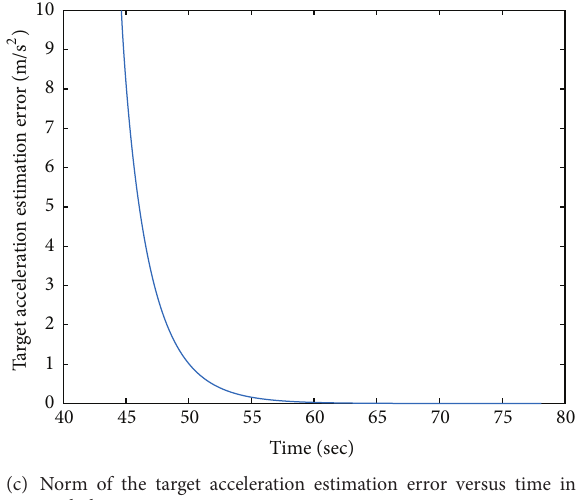
(c) Norm of the target acceleration estimation error versus time in terminal phase Figure 8: Filter performance versus time in terminal phase for intercepting high altitude-low velocity